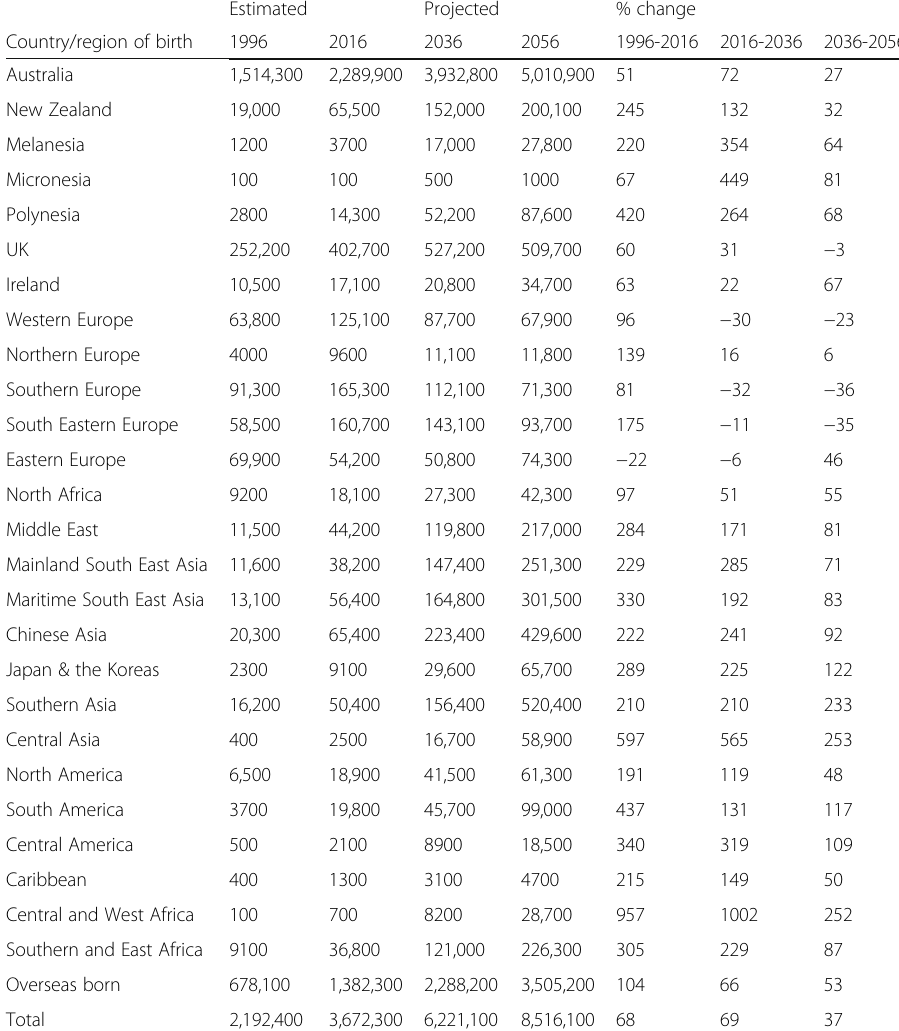
Table 2 The past and projected population of Australia aged 65+ by main birthplace category, 1996-2056